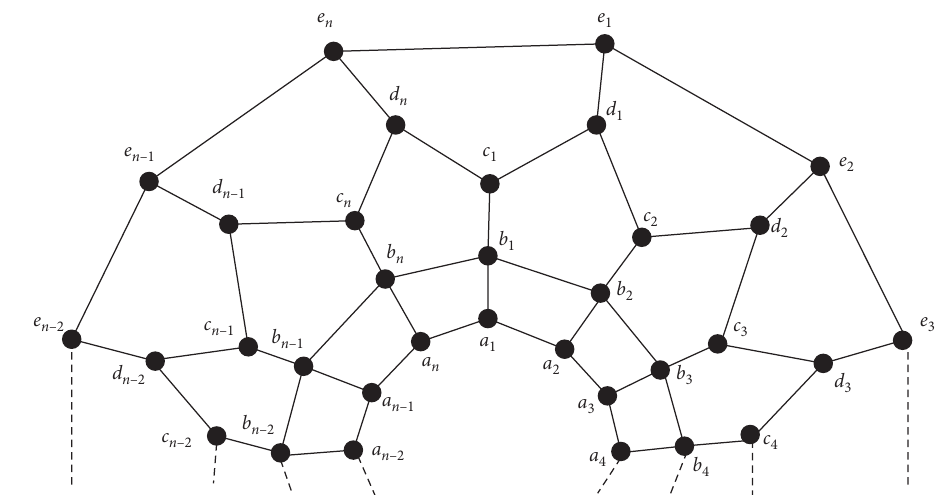
Figure 1: General half view of U